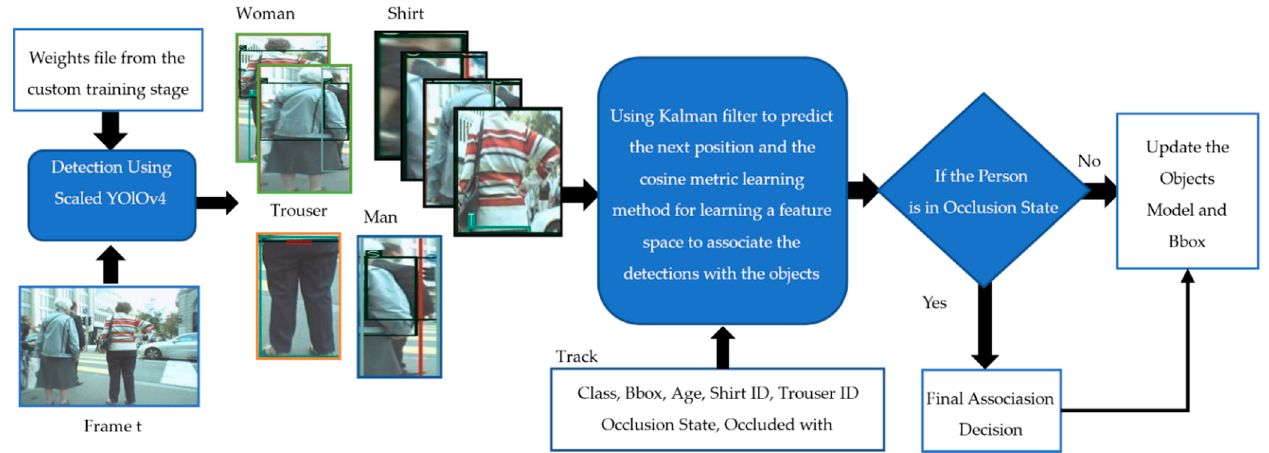
Figure 1. Overview of MSA-AF starting from the detection step, which feeds into the first association step. The final asso- ciation step will be used in cases of occlusion. Track 1 to Track n represents the model of the object that has been tracked in the previous frames. A class could be 0, 1, 2, or 3, representing man, woman, shirt, and trousers. Bbox has x,y,h,w of the object’s bounding box, in which (x,y) represents the centre point, h is the height, and w is the width. The occlusion state is a binary number: ‘1’ if the object is in an occlusion state and ‘0’ if not. Occluded with has the ID of the object that was occluded. Age is the number of frames in which the object is successfully tracked. Finally, Semantic information includes much information that will be described in detail in Section 3. The original image is taken from the MOTChalleng dataset [28].